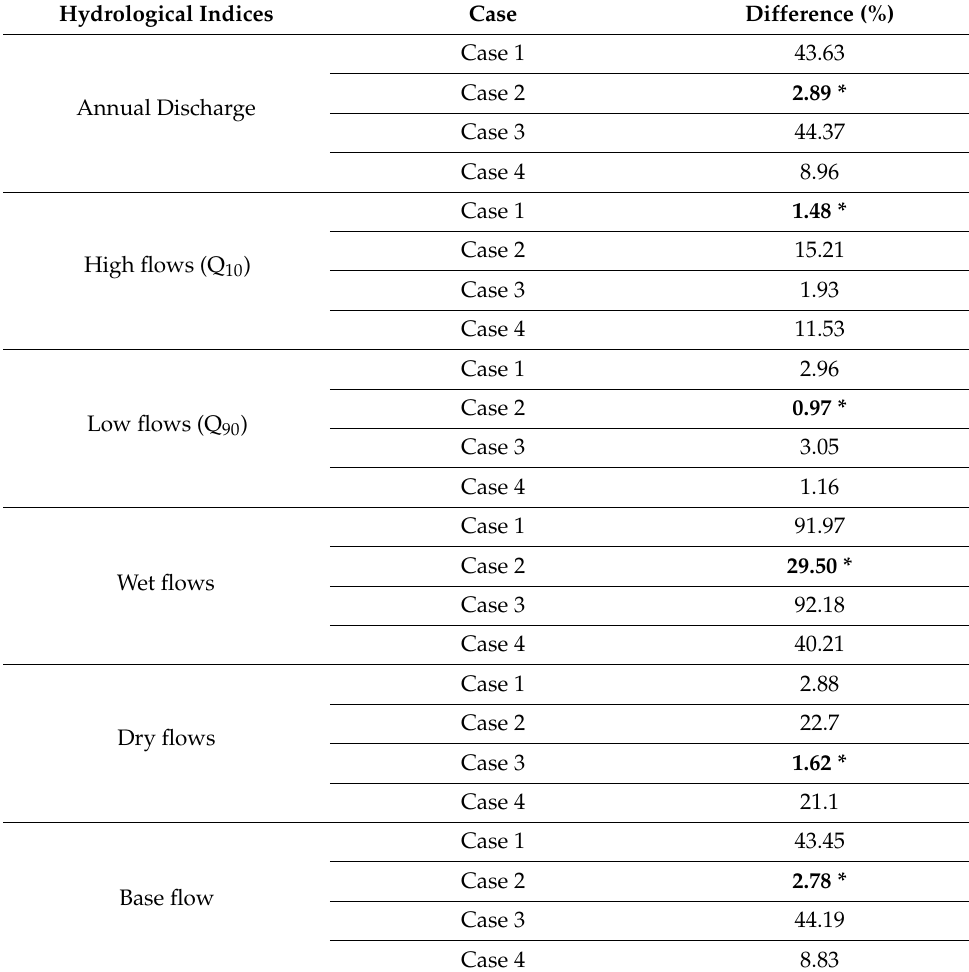
Table 4. Performance of mHM in simulating hydrological